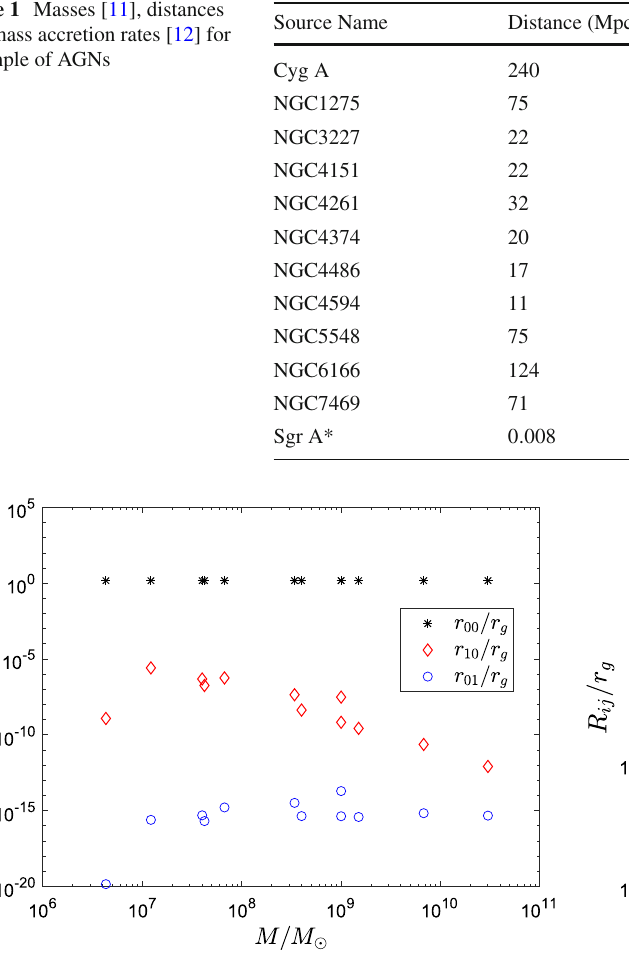
Fig. 1 Influences of the plasma on the radius of the black hole shadow for model A in Sect. 4. Left panel: the radius of the photon sphere and corrections to it according to Eq. (21) and Table 1 with λ 0 = 0 . 13cm. Right panel: the radius of the shadow and corrections to it according to